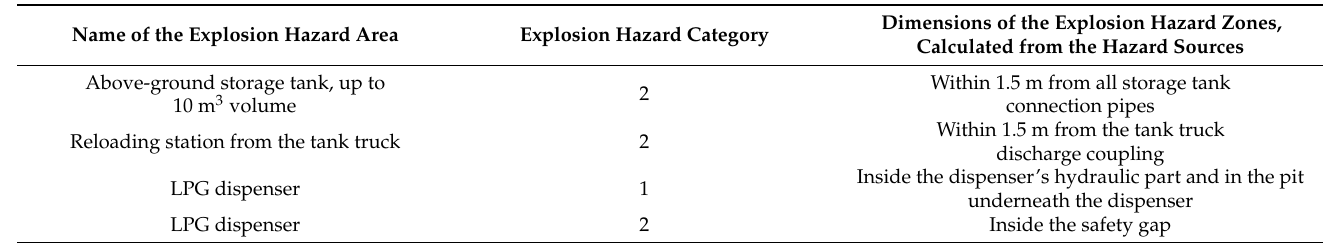
Table 4. Explosion hazard zone for the normal operation of a filling station according to Annex 1 of Regulation